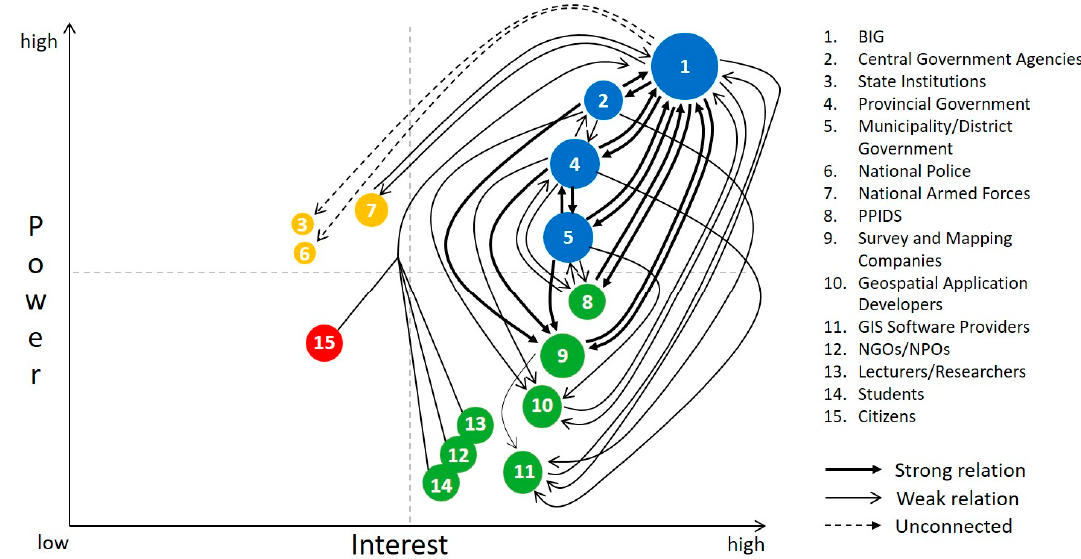
Table 3. Number of connections among national spatial data infrastructure stakeholders. No.